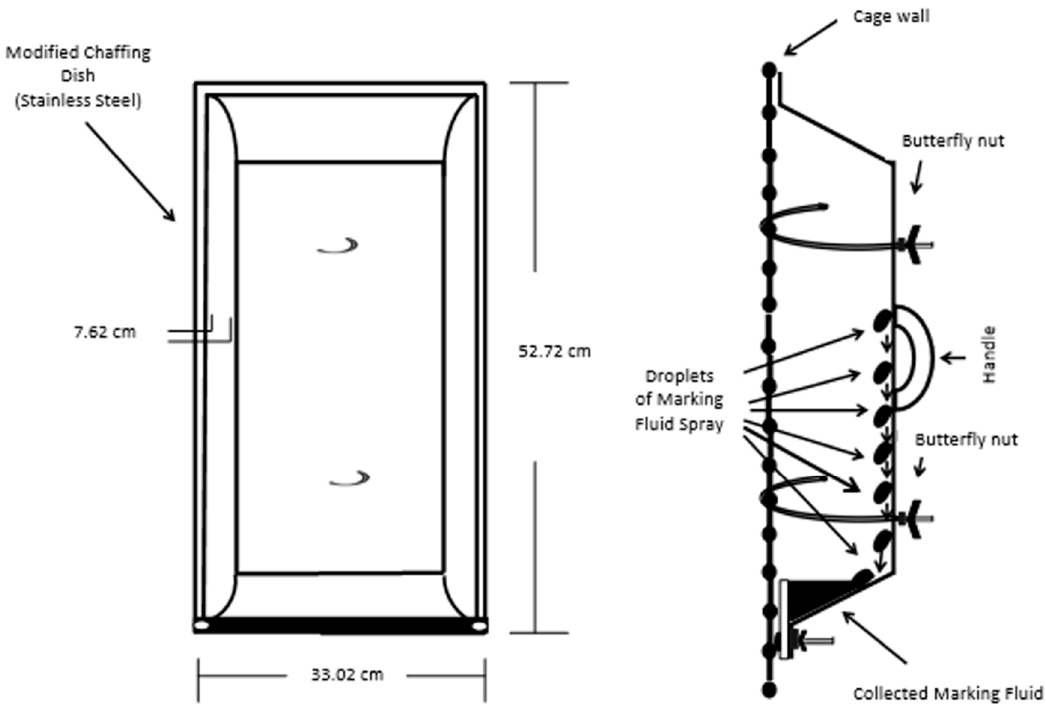
Figure 6. Marking fluid collection device and mode of collection.